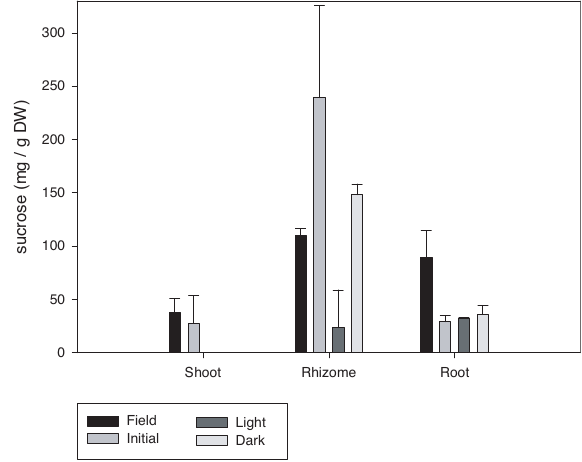
F IG . 3. – Sucrose (mg /g DW) in shoots, rhizomes and roots of Cymodocea nodosa plants freshly collected from the field (“field”), after a four month dark period (“initial”) and after a subsequent recovery experiment in very low light (“LL”) and high light (“HL”). Error bars represent 1 SD (n =